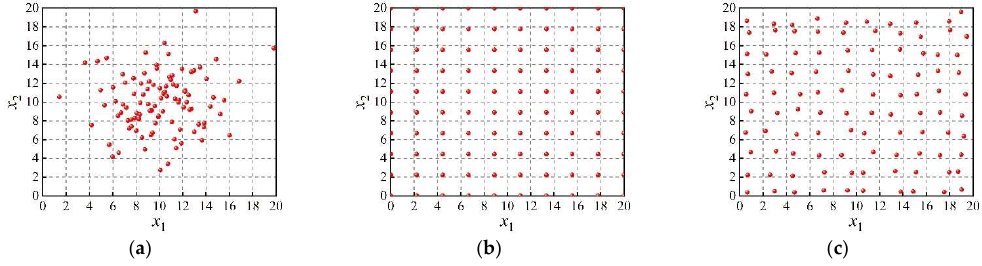
Figure 3. Scatter plot of different sampling methods. ( a ) LHS; ( b ) RGS; ( c ) RMQGS.